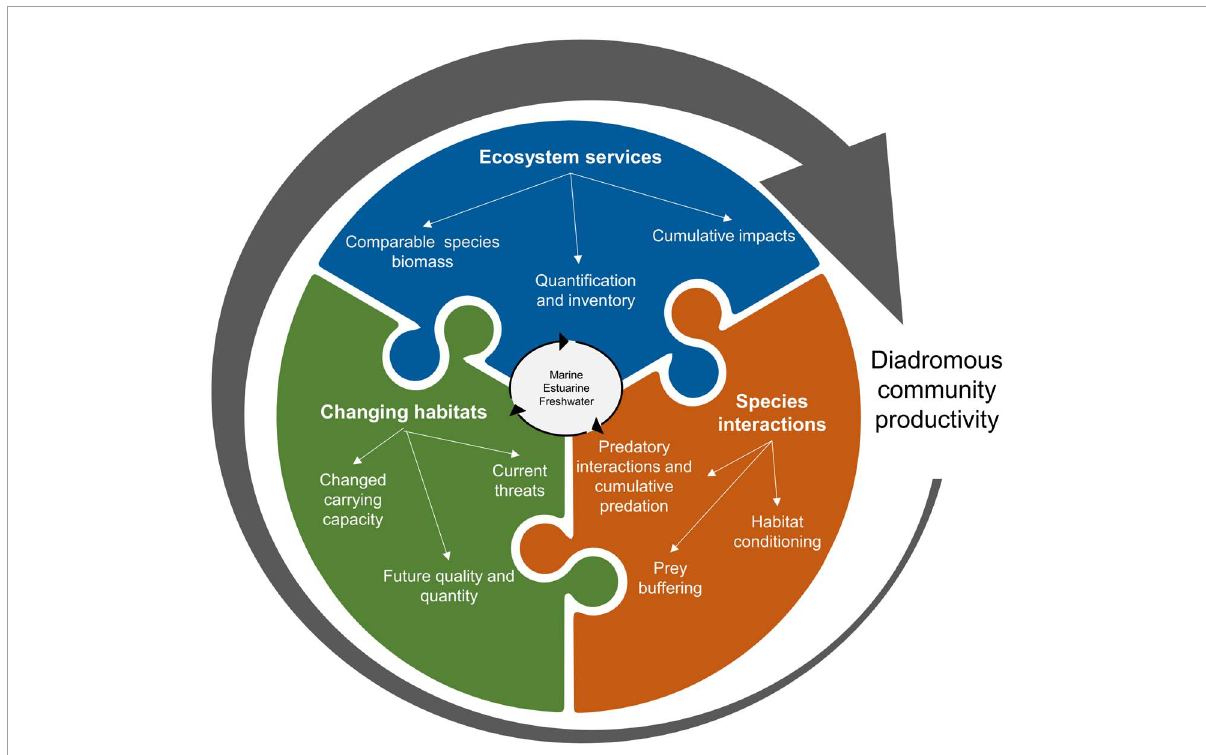
FIGURE7 Some research gap groups must be addressed to inform large-scale management of the diadromous community sphere ( Figure 6 ).